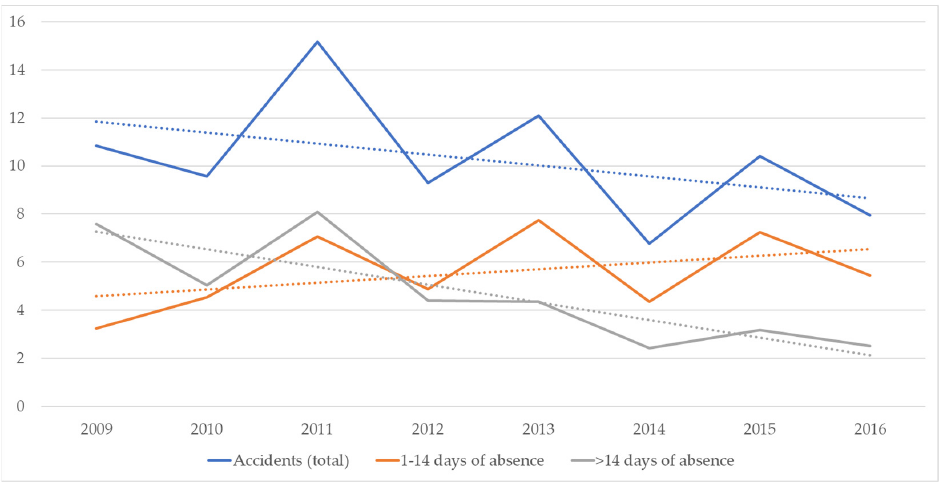
Figure 11. Incidence rates in site preparation/test drilling and boring. Based on data from [17 – 24,27] .